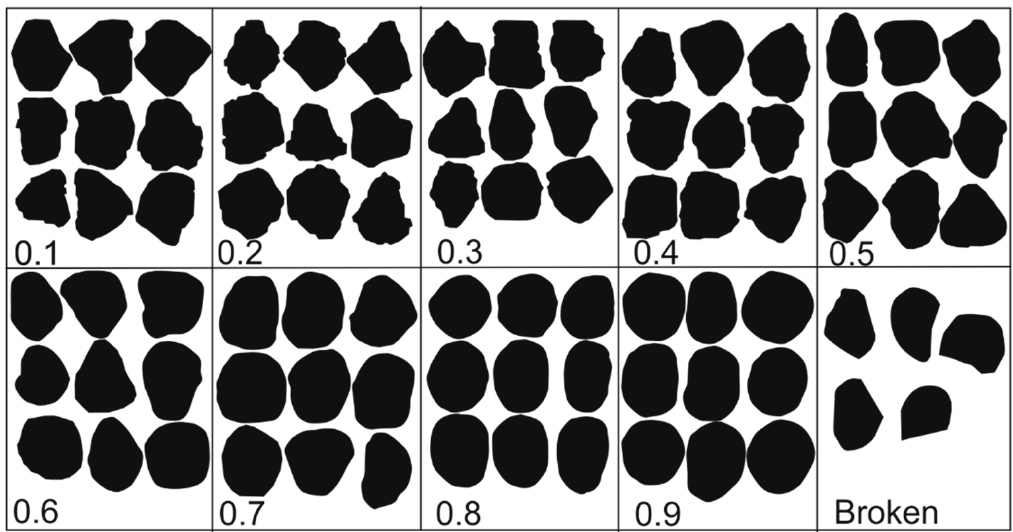
Figure 1. Patterns of grain roundness classes by Krumbein’s chart [4].